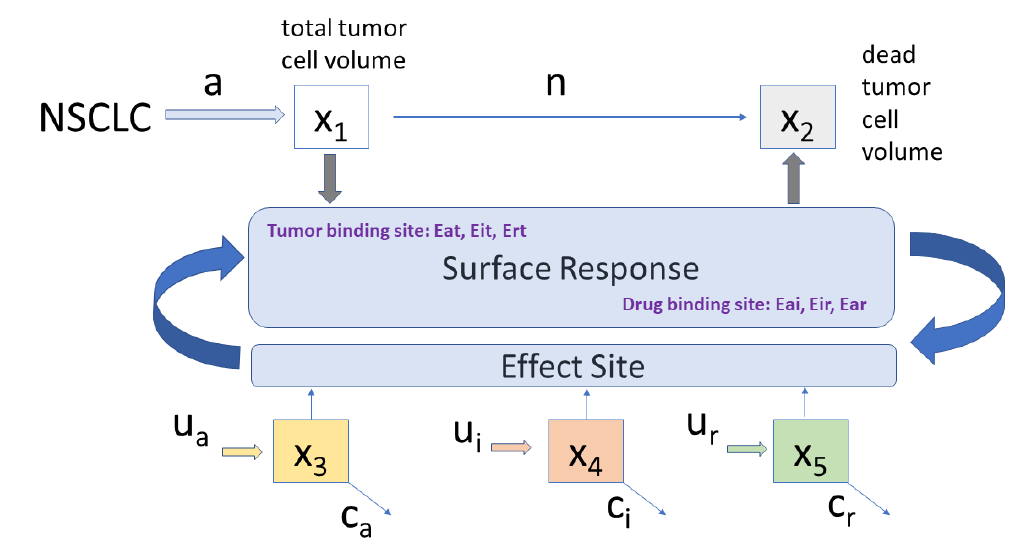
Figure 1. This is a schematic overview of the PKPD compartmental